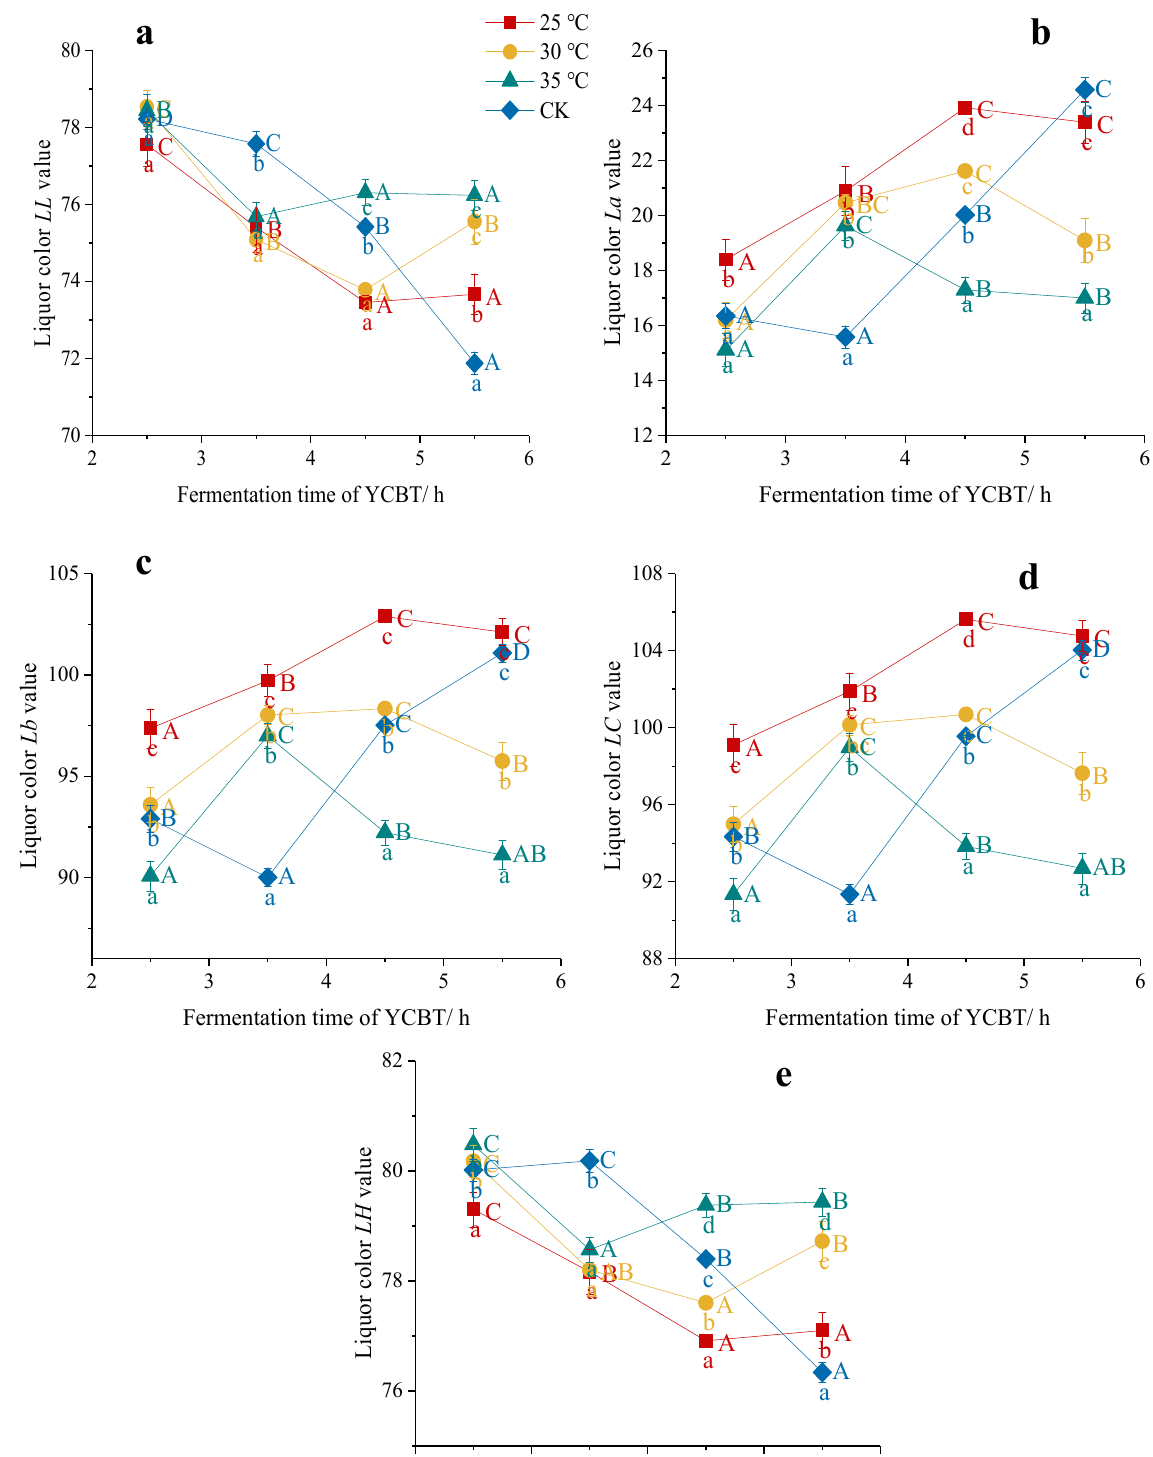
Figure 3. Effect of the fermentation temperature and time on the liquor color of Yunnan Congou black tea (YCBT) fermentation: ( a ) LL value, ( b ) La value, ( c ) Lb value, ( d ) LC value, and ( e ) LH value. Note: Mean values with different lowercase letters indicate significant differences between different fermentation temperatures at the same fermentation time ( p < 0.05); Mean values with different capital letters indicate significant differences between different fermentation times at the same fermentation temperature ( p <